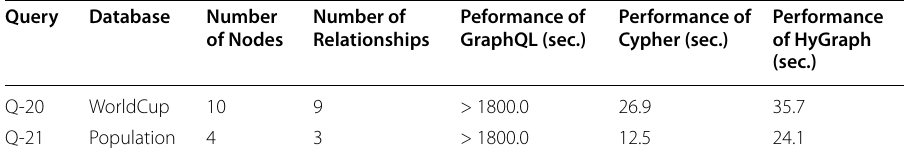
The timings are given in terms of seconds